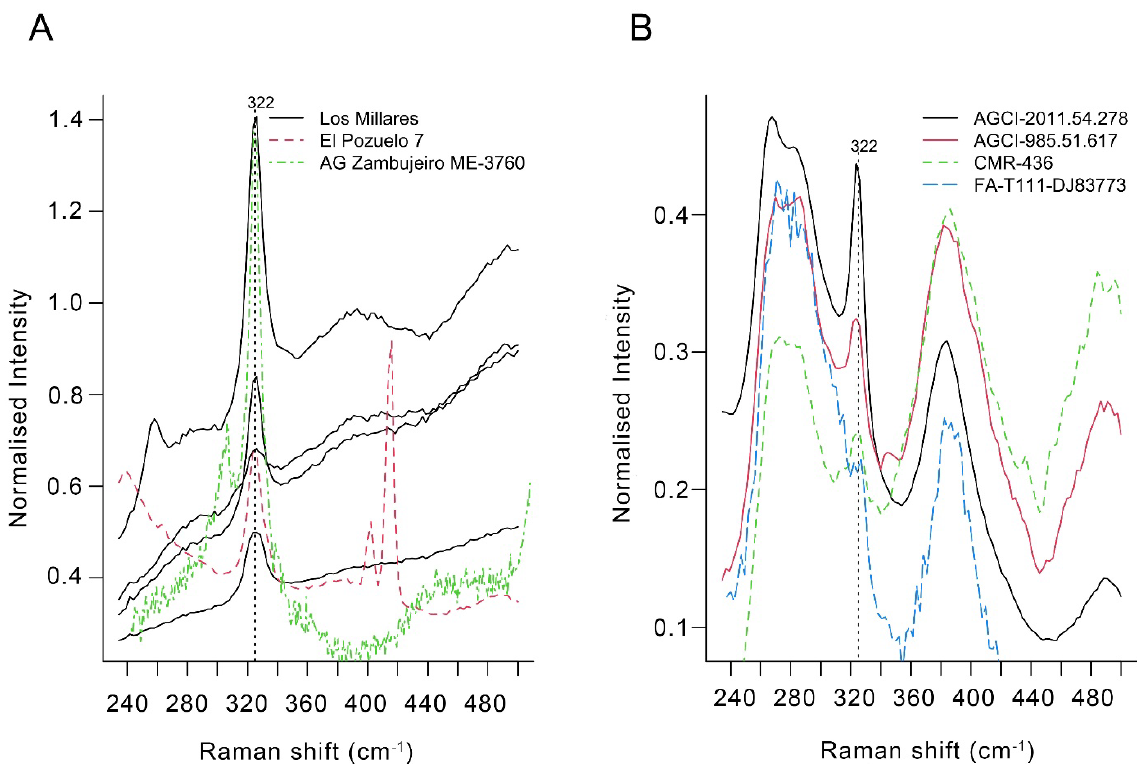
Figure 3. Raman spectra in the diagnostic region, left) set of samples that shows solely the fluorite diagnostic T 2g Raman band at c. 320 cm -1 , right) set of samples that shows the fluorite diagnostic T 2g Raman band at c. 320 cm -1 and additional bands at lower and higher